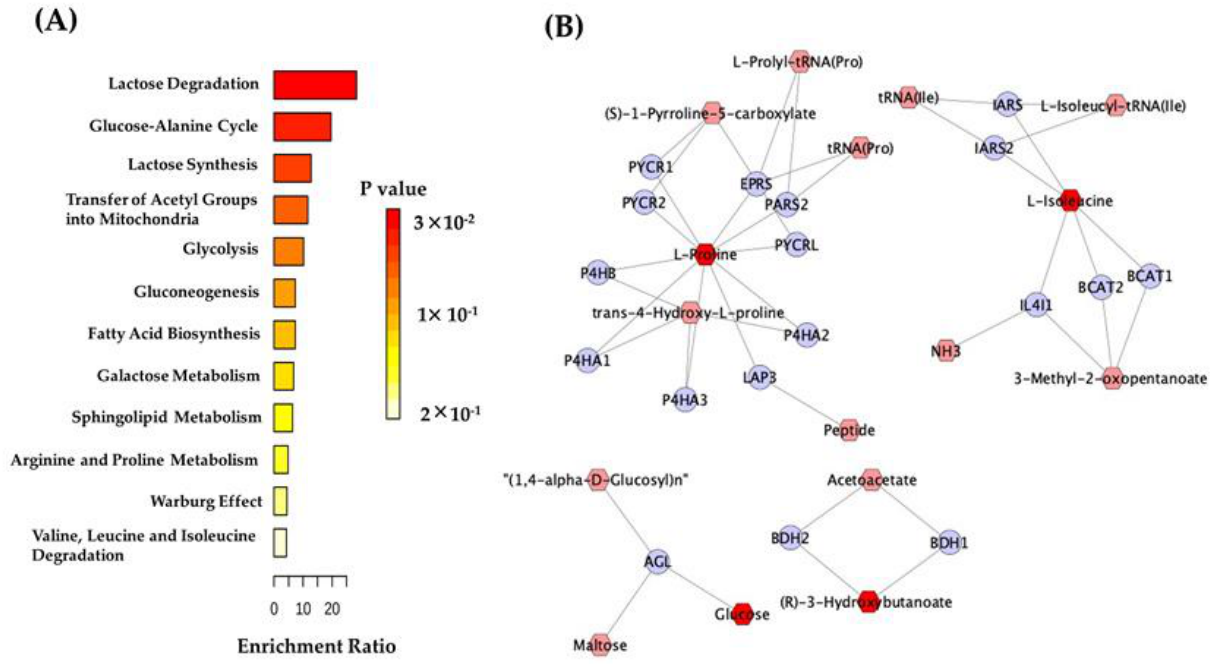
Figure 4. Metabolic pathways were identified by the Metabolite Set Enrichment Analysis (MSEA) of the discriminant metabolites that were identified when comparing ( A ) patients and controls. ( B ) Network compound genes built with the discriminant metabolites comparing patients and controls. Blue circles—annotated genes; pink hexagon—metabolite’s ligands; red hexagon—discriminant metabolites present in the KEGG database.